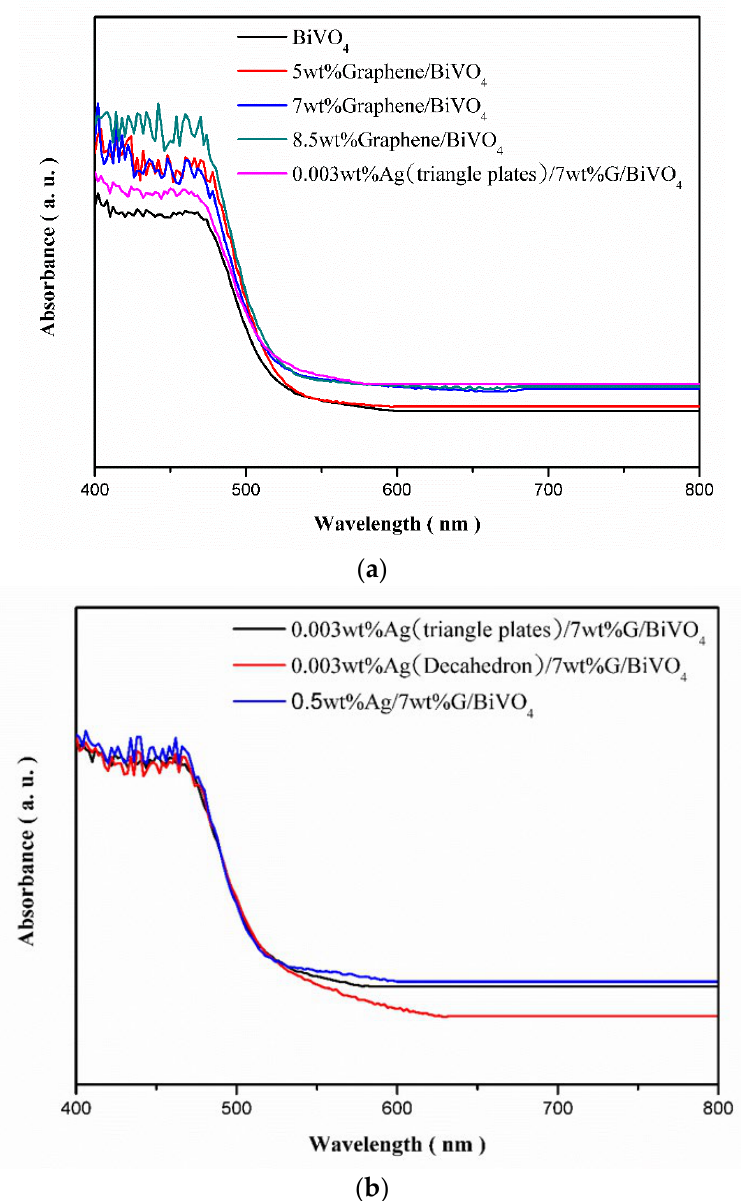
Figure 5. UV–Vis absorption spectra of the obtained photocatalysts ( a ) by varioue loading amounts of graphene to BiVO 4 ( b ) by various kinds of silver on 7% graphene/BiVO 4 . Table 2. Band gap calculation of the obtained photocatalysts.